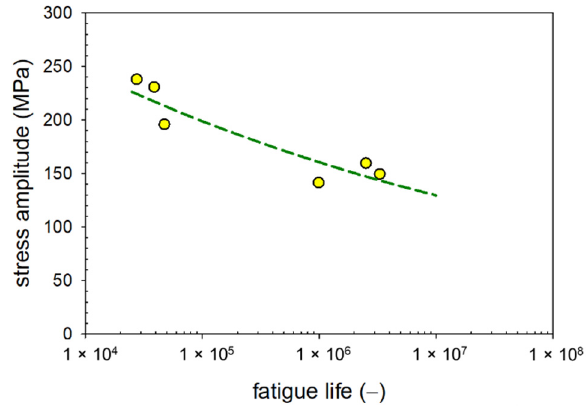
Figure 7. Wöhler curve of laser-welded P265GH steel.